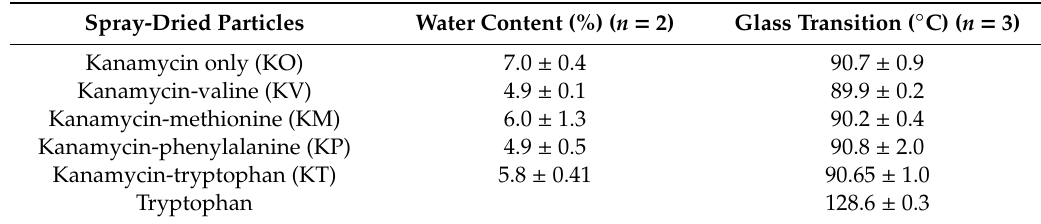
Table 2. Water content and glass transition of the different spray-dried particles. Values are expressed as mean ± standard deviation.